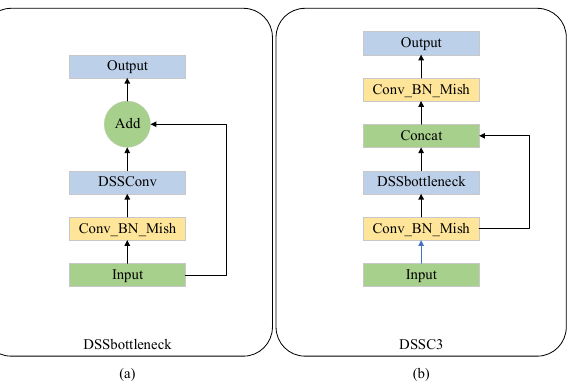
Figure 3. ( a ) The calculation process of the DSC. ( b ) The structure of the DSSConv module. We designed DSSbottleneck and DSSC3 based on the bottleneck and C3 modules of YOLOv5, whose structures are presented in Figure 4a,b.